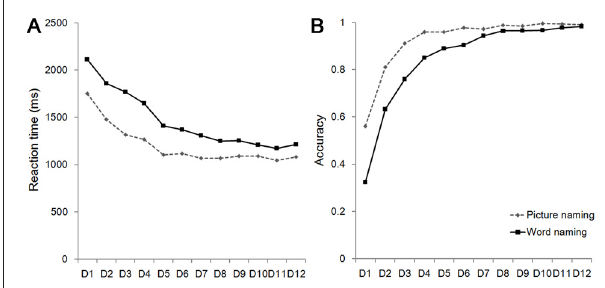
FIGURE 2 | Reaction time (RT; A ) and accuracy (B) on the word naming and picture naming tasks. D,